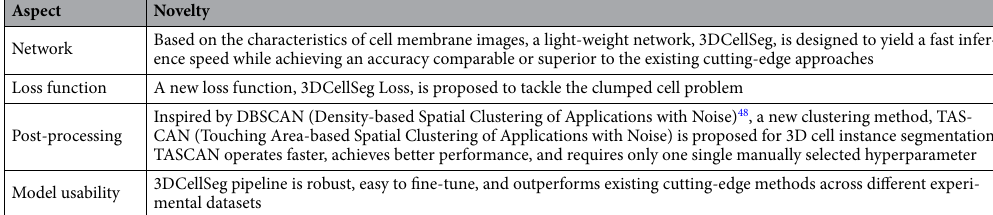
Table 2. Key novelties of